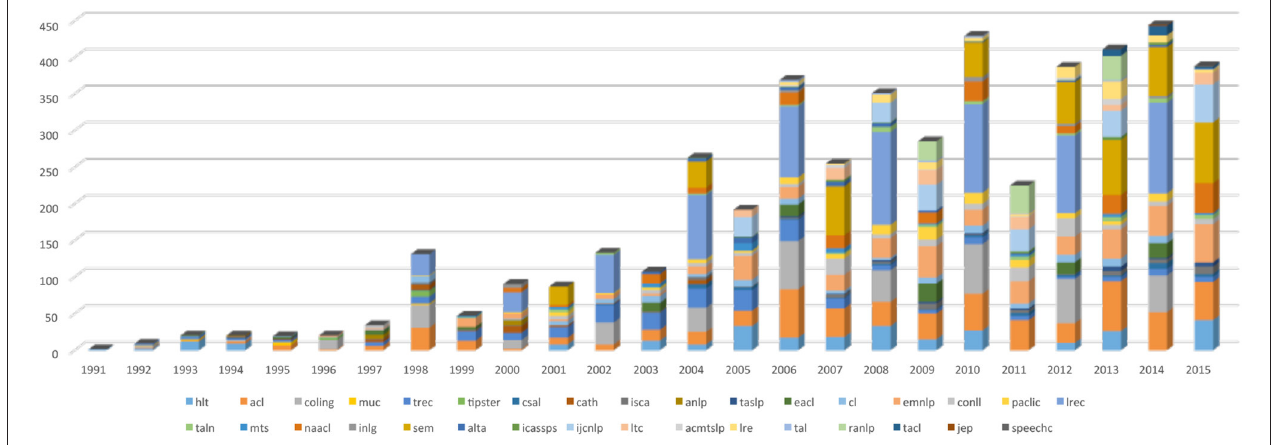
FIGURE 22 | Propagation of the mention of the “Wordnet” resource in NLP4NLP conferences and journals, including the number of mentions.